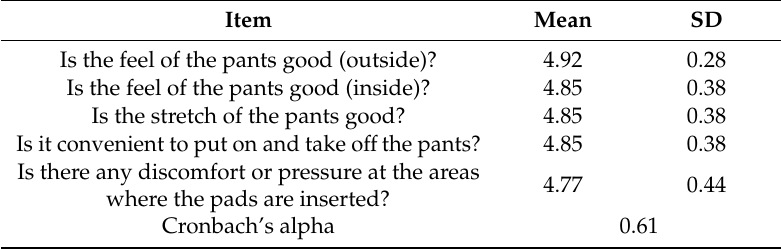
Table 10. Results of the evaluation of wearing characteristics ( n =